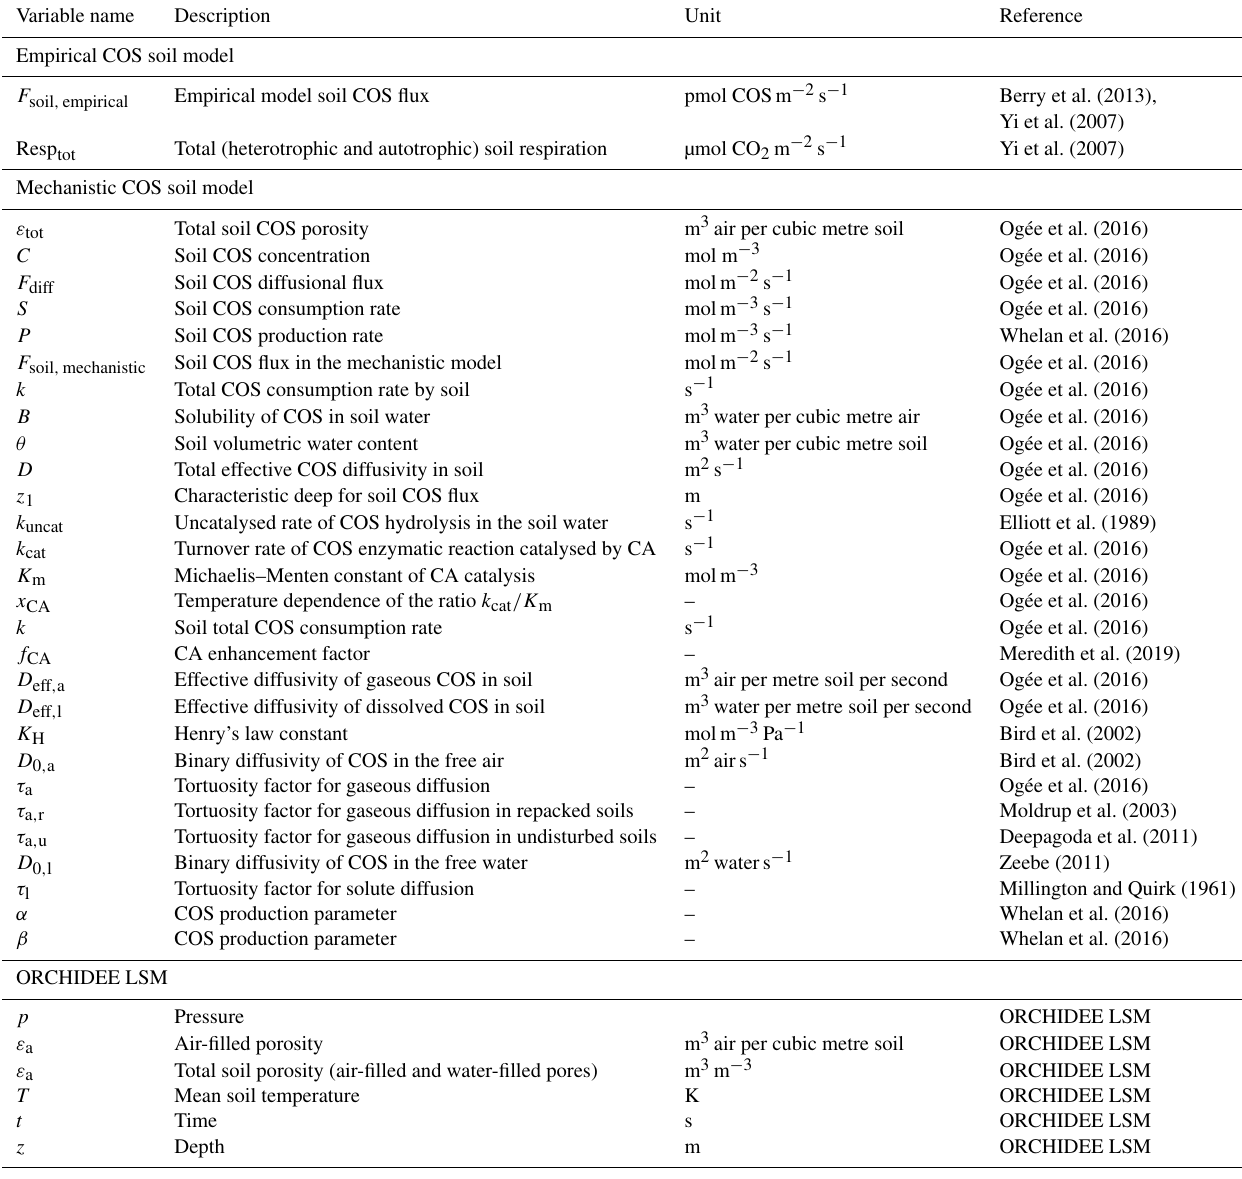
Table A3. Variables for the empirical and mechanistic COS soil